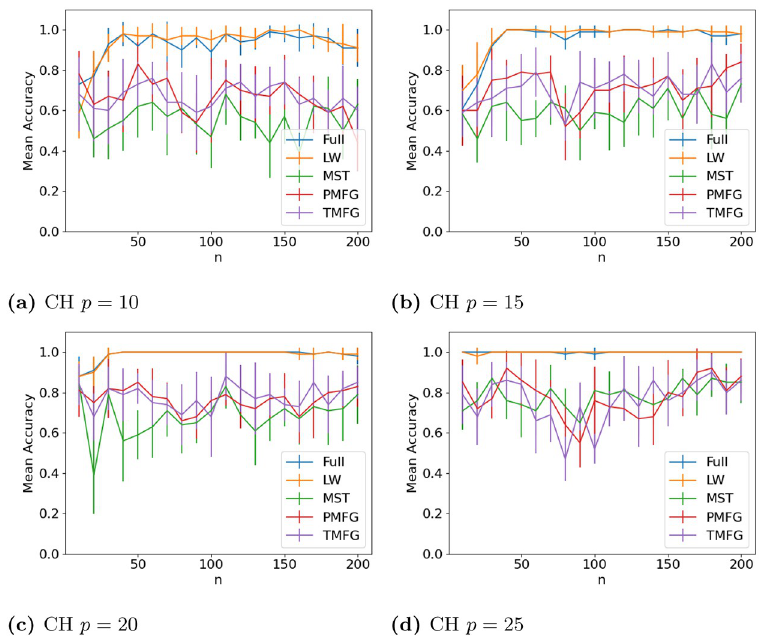
Fig 14. Accuracy when distinguishing between correlation matrices created from the stock windows with the maximum and minimum volatility using the SF method and a random forest classifier for China. (a) CH p = 10, (b) CH p = 15, (c) CH p = 20, (d) CH p = 25.